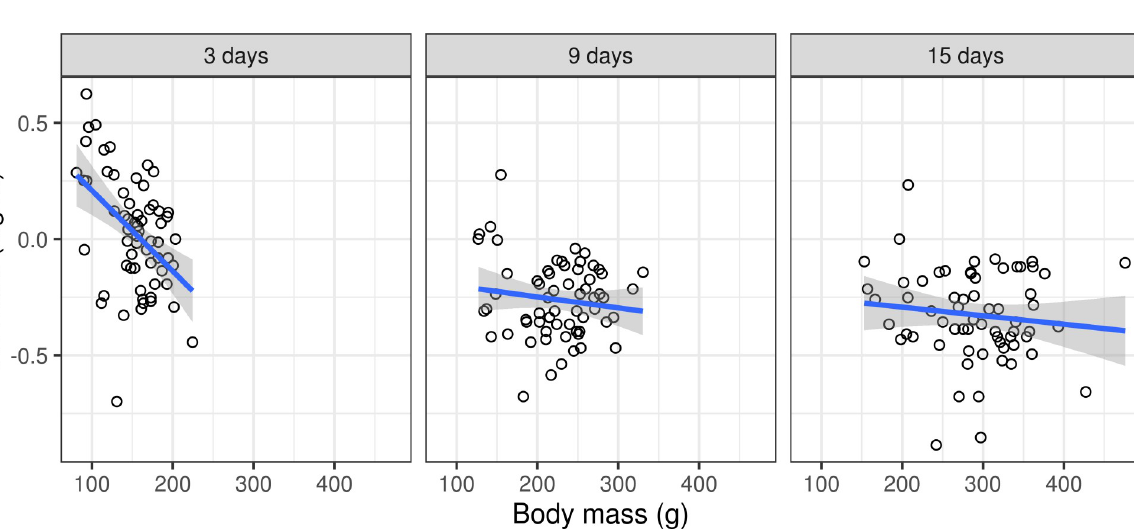
Fig 4. Variation in mallard heterophil vs. lymphocyte (H/L) ratio due to the effect of body mass (n = 64). Predictions are based on mixed models and shaded areas correspond to 95% confidence intervals.